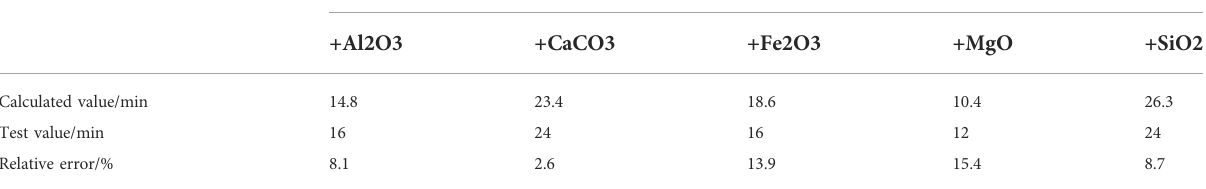
TABLE 9 Demulsi fi cation time of the STAC emulsi fi ed asphalt. Demulsi fi cation